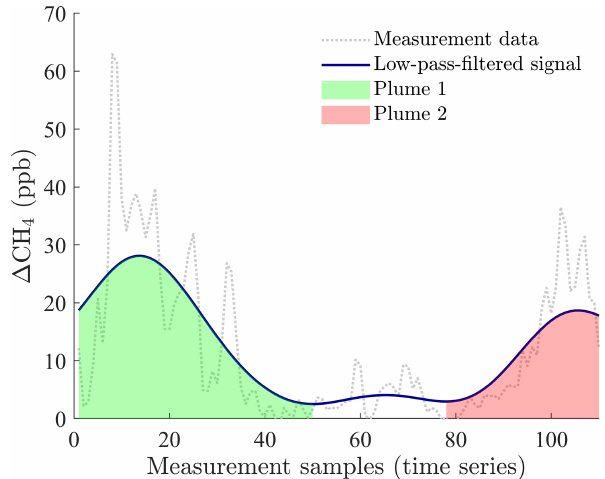
Figure 1. The preprocessed measurement signal (dotted line, mov- ing average with window size of 10s and step size of 5s) is shown along with a low-pass-filtered version (blue line), which is used to obtain the single plumes (green and red area). The signal in the center is not detected as a plume, as the enhancement is not high enough. The round shown was recorded by bike and took 550s (9.2min).